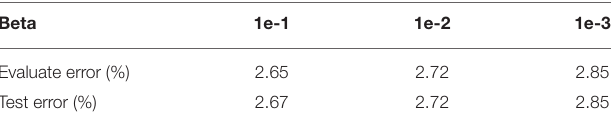
TABLE 3 | Comparison of errors on MNIST